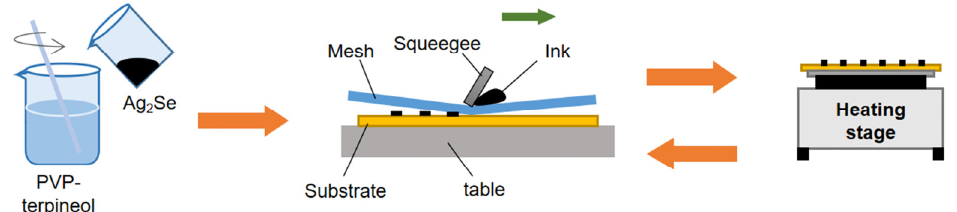
Figure 1. Schematic of the manufacturing process of the Ag 2 Se/PVP